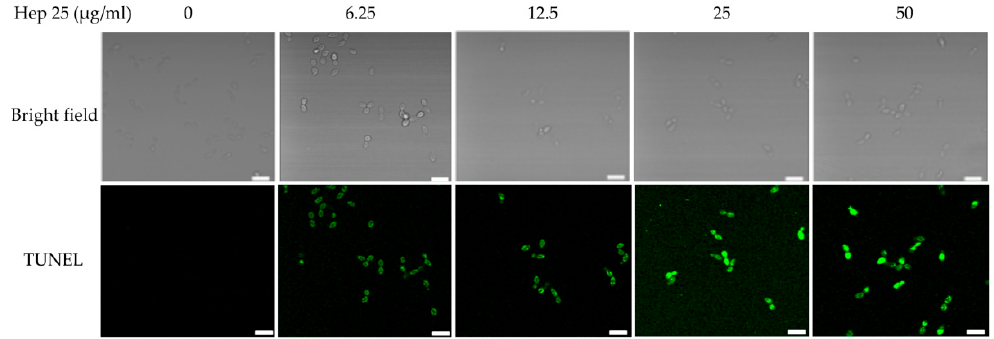
Figure 9. DNA fragmentation caused by hep 25. Cells were treated with various concentrations of hep 25, and the DNA damage was determined using the TUNEL assay. Images were taken using a laser scanning confocal microscope with a 60 × oil objective lens. Bar, 10 µ m. The representative images from three independent experiments with similar results are shown.